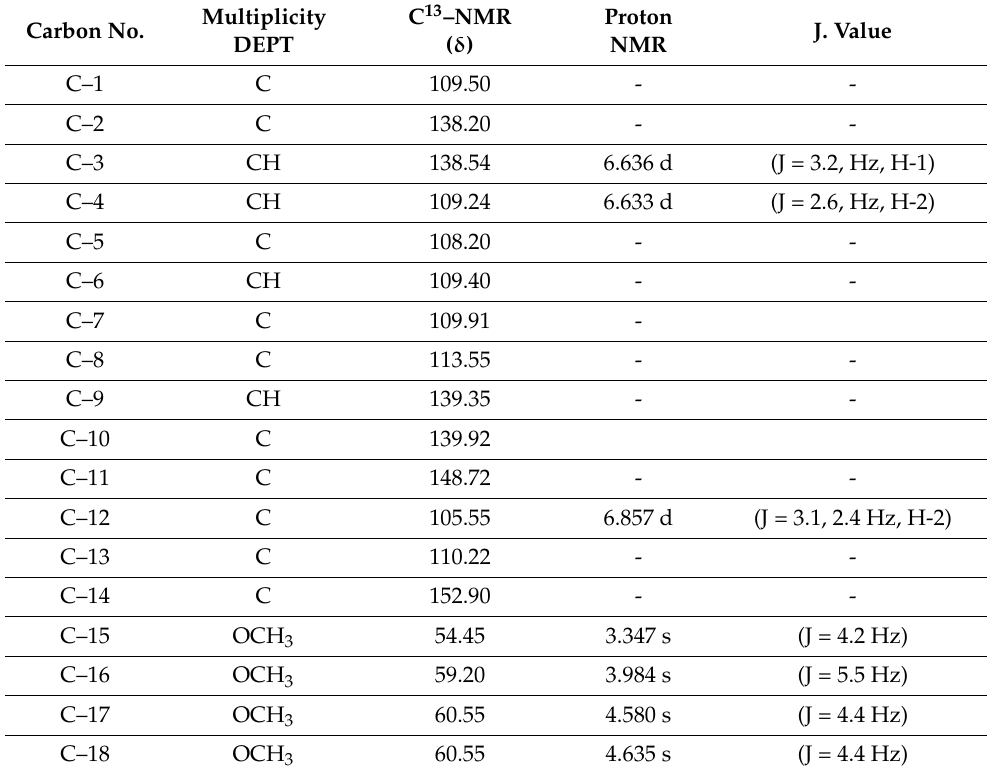
Table 1. 13 C-NMR (125 MHz) or Chemical shift ( 1 H-NMR 500MHz) spectral data of “LFD”. Carbon